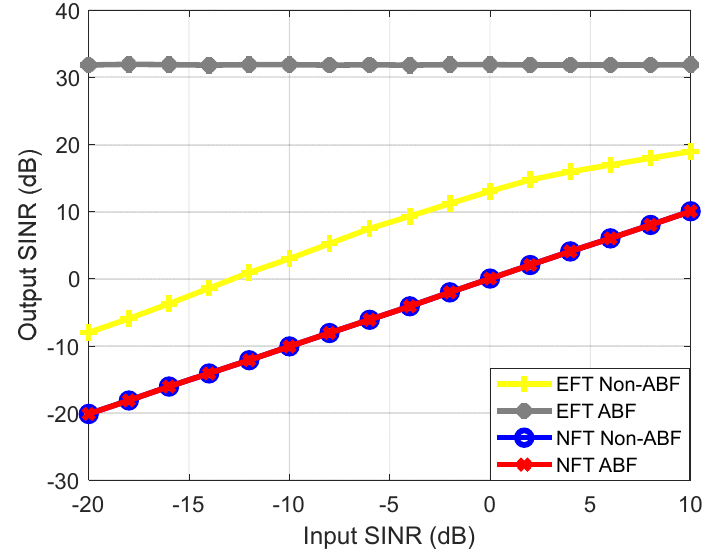
Figure 11. The output SINR performance comparison of jamming technology.